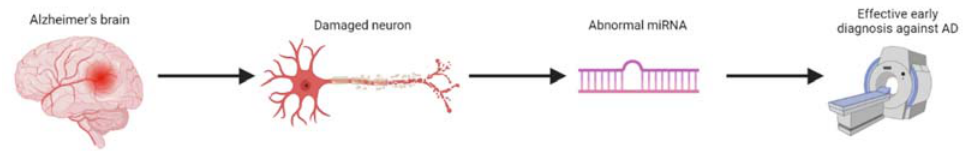
Figure 9. Potential of miRNAs as biomarkers for the early diagnosis of AD.